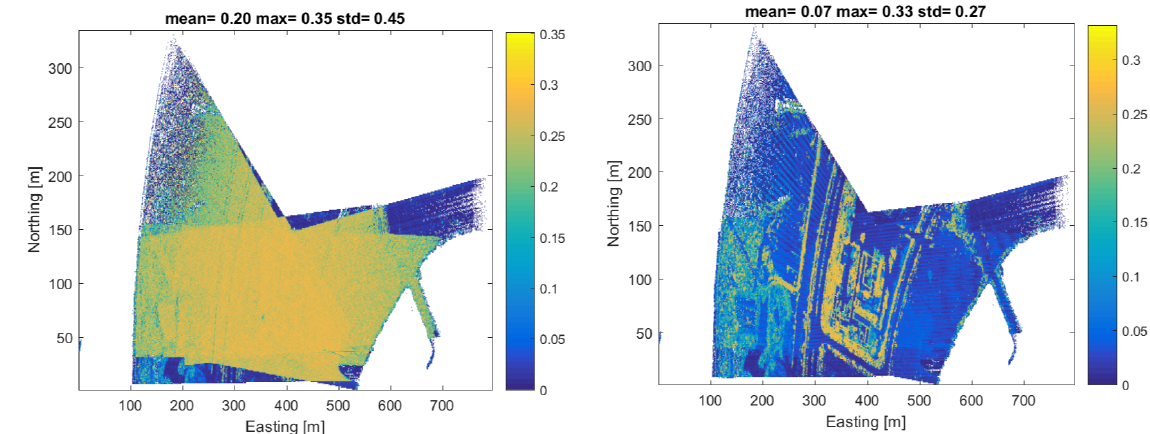
Figure 13. VUX-LR LiDAR before ( left ) and after ( right ) LIBAC.